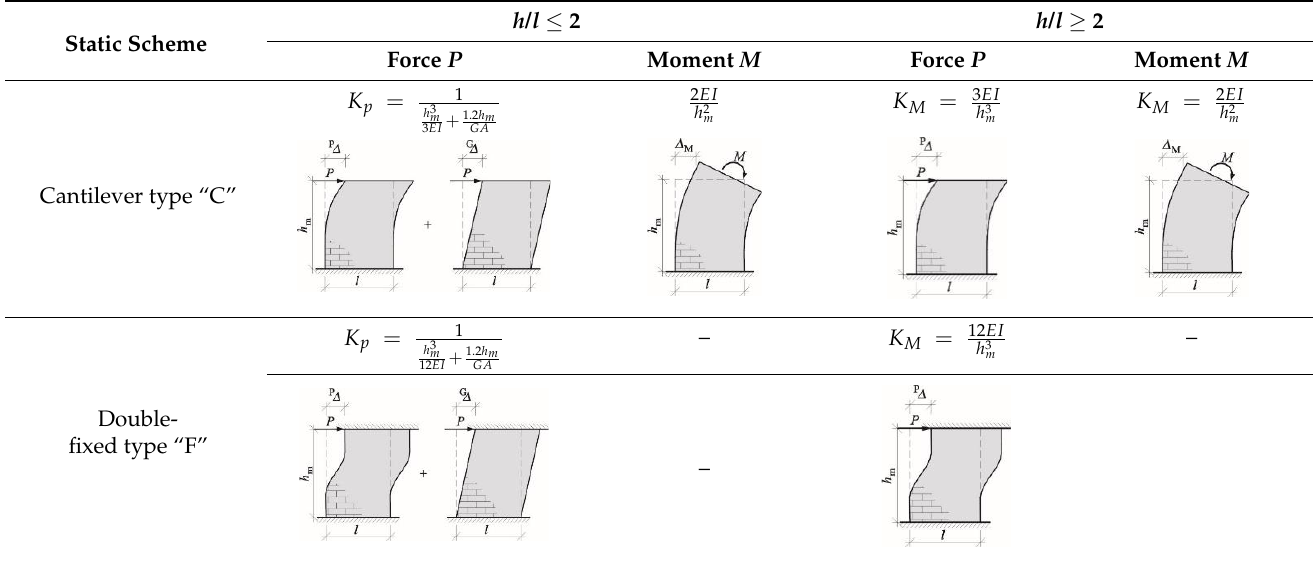
Table 7. Stiffness of walls subjected to shear with bending.